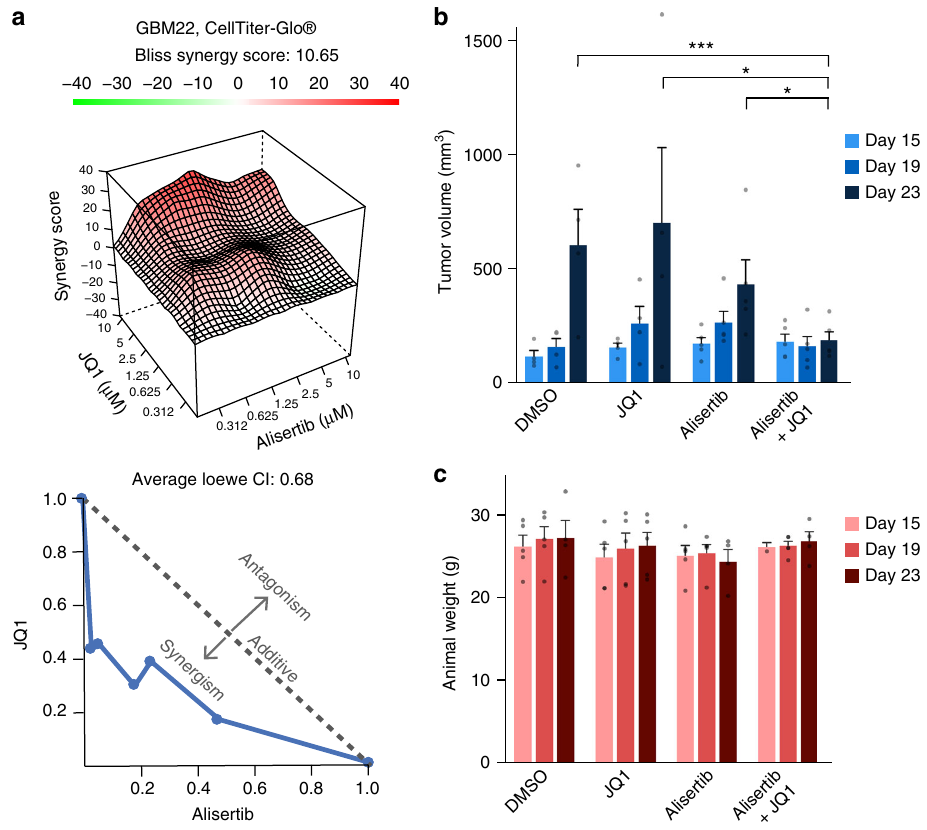
Fig. 6 JQ1 and alisertib synergize in vitro and in vivo in reducing GBM tumor growth. a Synergistic response of JQ1 and alisertib measured by ATP levels using CellTiter-Glo ® in GBM22 PDX cells. ATP levels are normalized to positive control (Velcade) and negative control (DMSO). The Bliss score surface (top) and isobologram plot of the Loewe combination index (bottom). b Synergistic response observed for JQ1 and alisertib combination in vitro in a fl ank model of GBM, measured by caliper. Mice were implanted with GBM22 PDX cells and treated starting at day 15 with 25 mg kg − 1 per day of alisertib and/or 30 mg kg − 1 per day of JQ1 for 10 days. Signi fi cance was determined using an unpaired t -test with Holm-Sidak correction for multiple comparisons, * p < 0.05, *** p < 0.001. c JQ1 and alisertib combination does not reduce mouse weight. Weight of mice analyzed in ( c ) was assessed at the indicated time points. Sample size was as follows: DMSO, JQ1 n = 4; Alisertib, Alisertib + JQ1 n = 5. Please note that one mouse in each the Alisertib and Alisertib + JQ1 group perished before 23-day animal weight was obtained. Mean and standard error bars are shown. Source data can be found in the Source Data fi